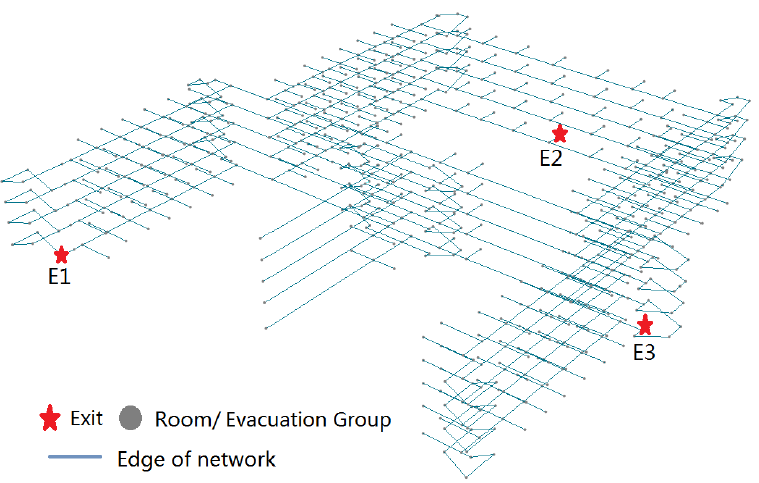
Figure 7. The indoor network model of the teaching building J6 of SDUST.